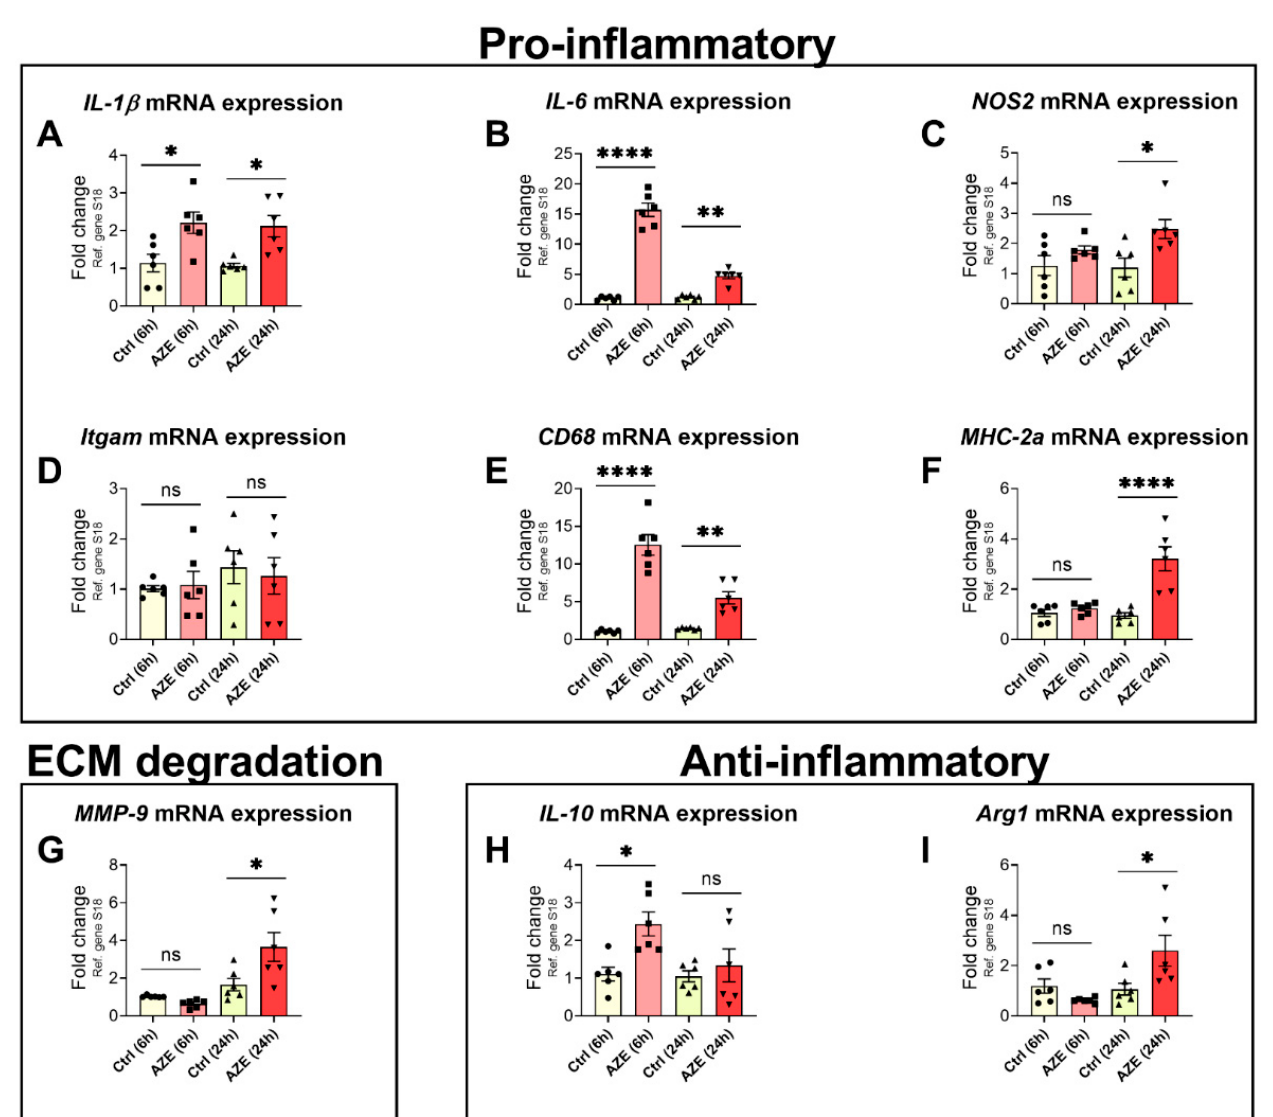
Figure 3. Gene expression of a panel of pro- and anti-inflammatory genes in BV2 microglial cells after 1000 µ M AZE treatment for 6 and 24 h. Relative fold-changes were calculated using the ∆ Ct method after normalization to the S18 housekeeping gene. Box-and-whisker plots depict the differential expression of pro-inflammatory ( A – F ) IL-1 β , IL-6, NOS2, Itgam, CD68 and MHC-2a , ( G ) extracellular matrix (ECM) degradation (MMP-9) and ( H – I ) anti-inflammatory IL-10 and Arg1 transcripts. Results are presented as mean fold changes with respect to no treatment (Ctrl) ± SEM. Data represents n = 6 samples per group. * p < 0.05, ** p < 0.01 or **** p < 0.0001; as determined by ANOVA followed by Sidak’s post hoc test. Ns = not significant.